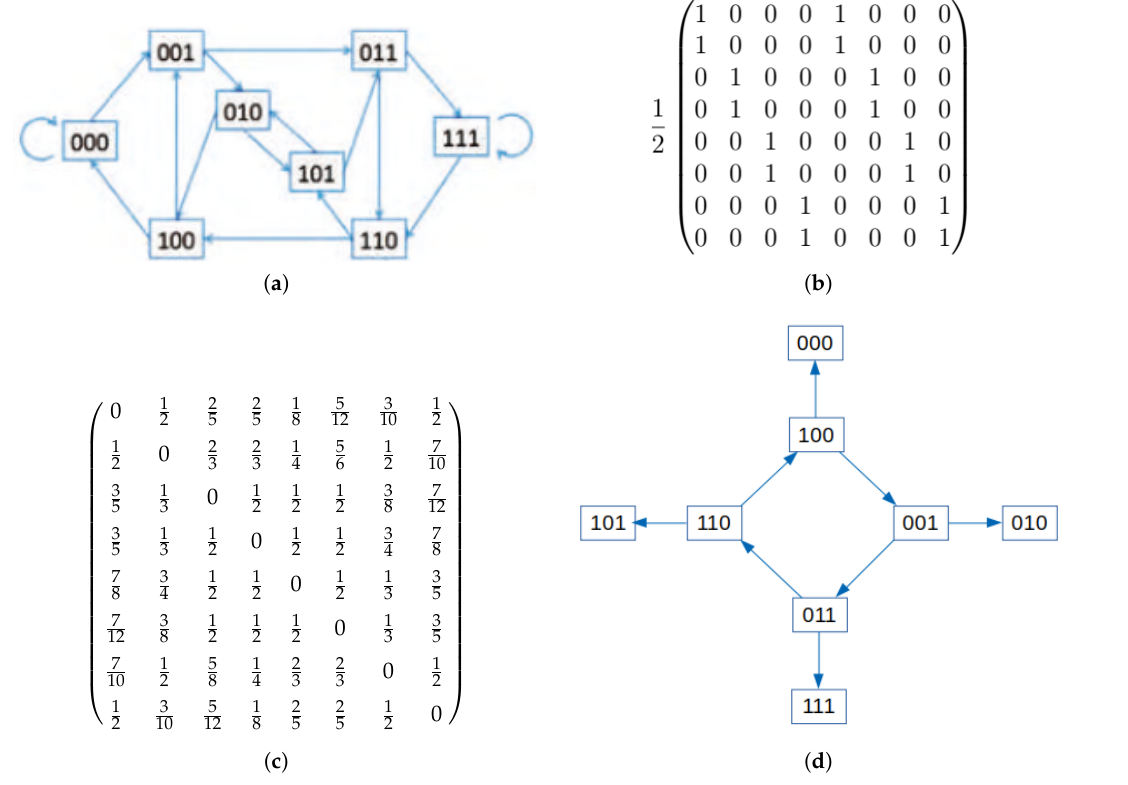
Figure 1. Analysis of the Penney Game with (cid:96) = 3, fair coins and fully absorbing traps. ( a ) Transition graph, where every node is a possibly winning sequence, the links go from one sequence to the sequences which can be obtained with a coin toss. Each link weights 1/2. ( b ) Weighted adjacency matrix (Markov matrix) M of the system, where the sequences (indexes) are read as base-two numbers. ( c ) Victory matrix and ( d ) victory graph, where arrows mark which sequence wins with the largest probability over the given